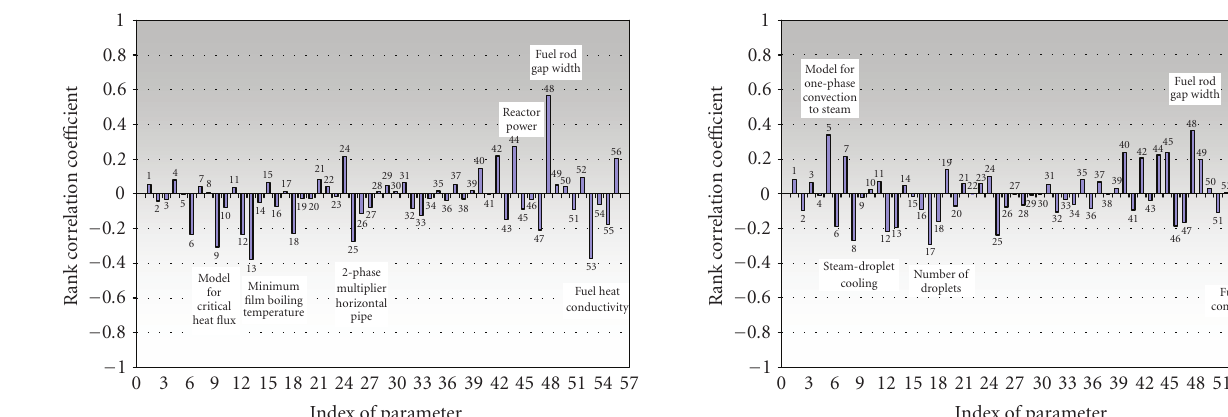
Figure 4: Sensitivity measures of the blowdown PCT with respect to the selected 56 uncertain input parameters (rank correlation co- e ffi cient) for the reference reactor large break.